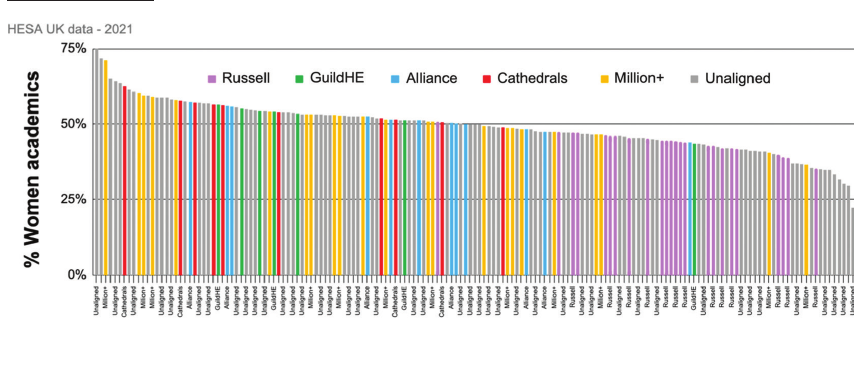
Fig. 5: Percentages of women in the non-atypical academic workforce in a subset of higher education institutions in the United Kingdom by institutional groupings, 2021. Data source: Higher Education Statistics Agency (2022). Analysis and image: Curtin Open Knowledge Initiative. The full list of institutions and data is available at Zenodo https://doi.org/10.5281/